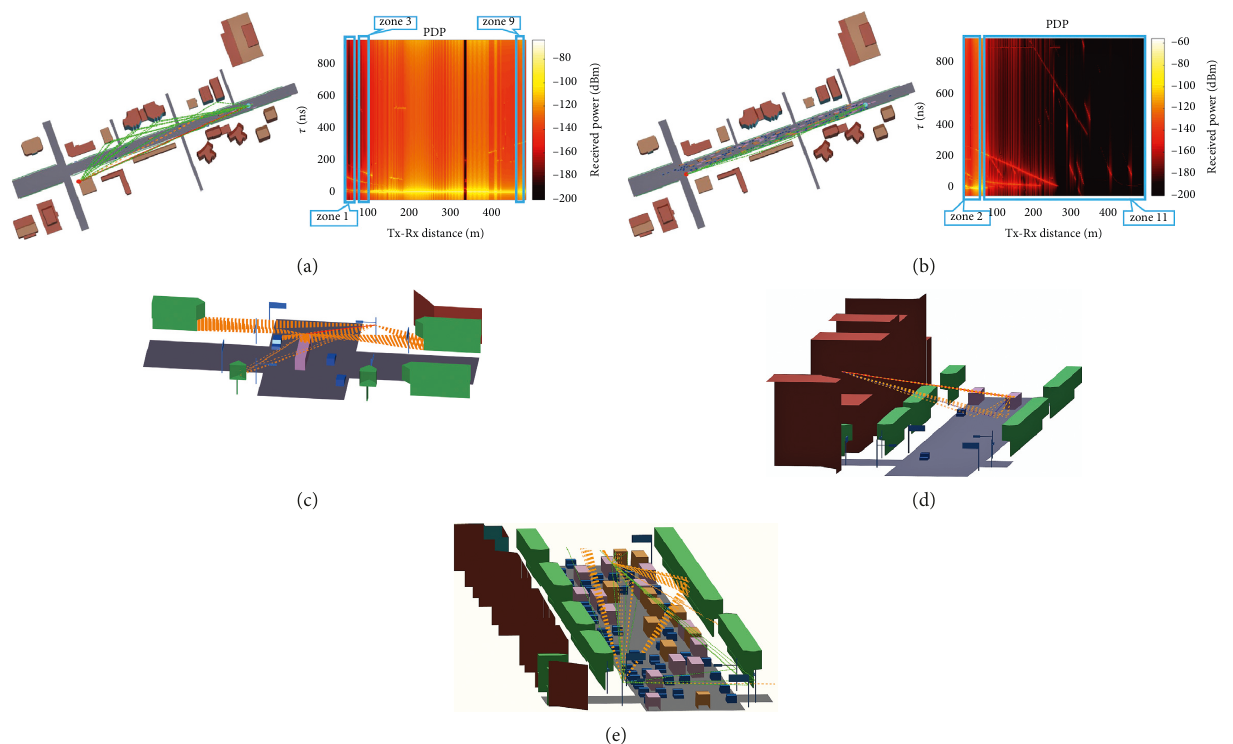
Figure 10: Exemplified RTsimulation results in different cases and zones. (a) Case 9: Seoul-8Lanes-Tx25-TFLow. (b) Case 10: Seoul-8Lanes-